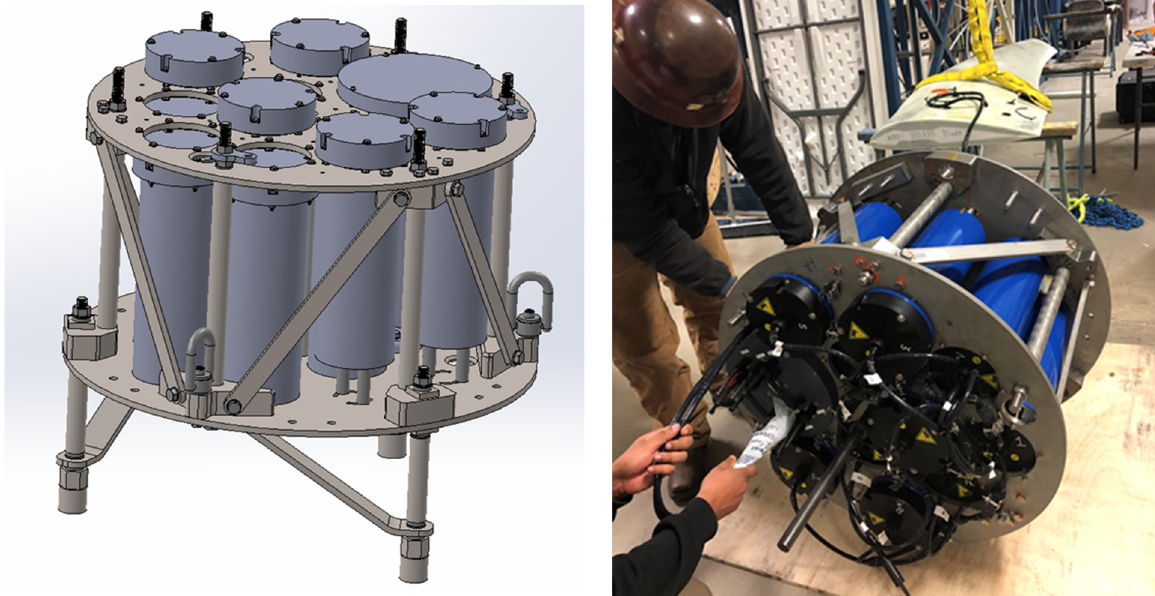
Figure 8. ( left ) 3D image of NDAQ structure; ( right ) thermoplastic blade being connected to NDAQ.